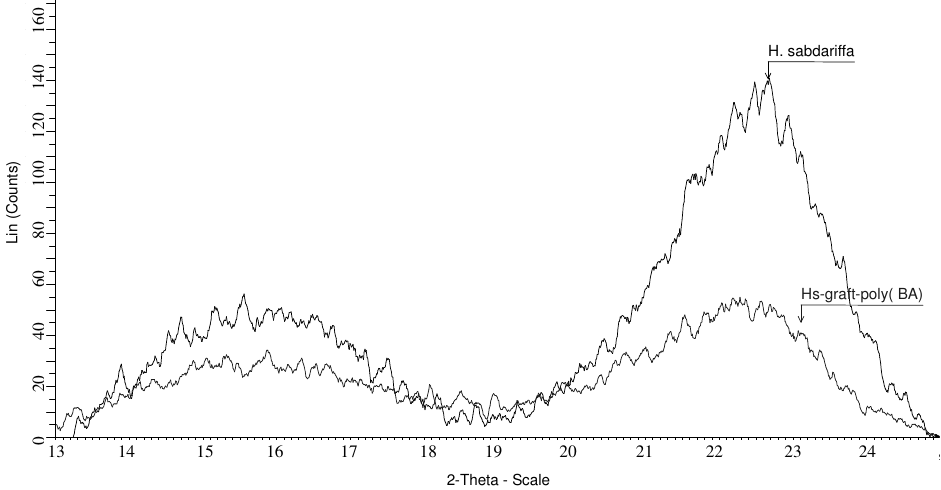
Figure 4. XRPD overlay pattern of Hibiscus sabdariffa and the highest grafted copolymer Hs